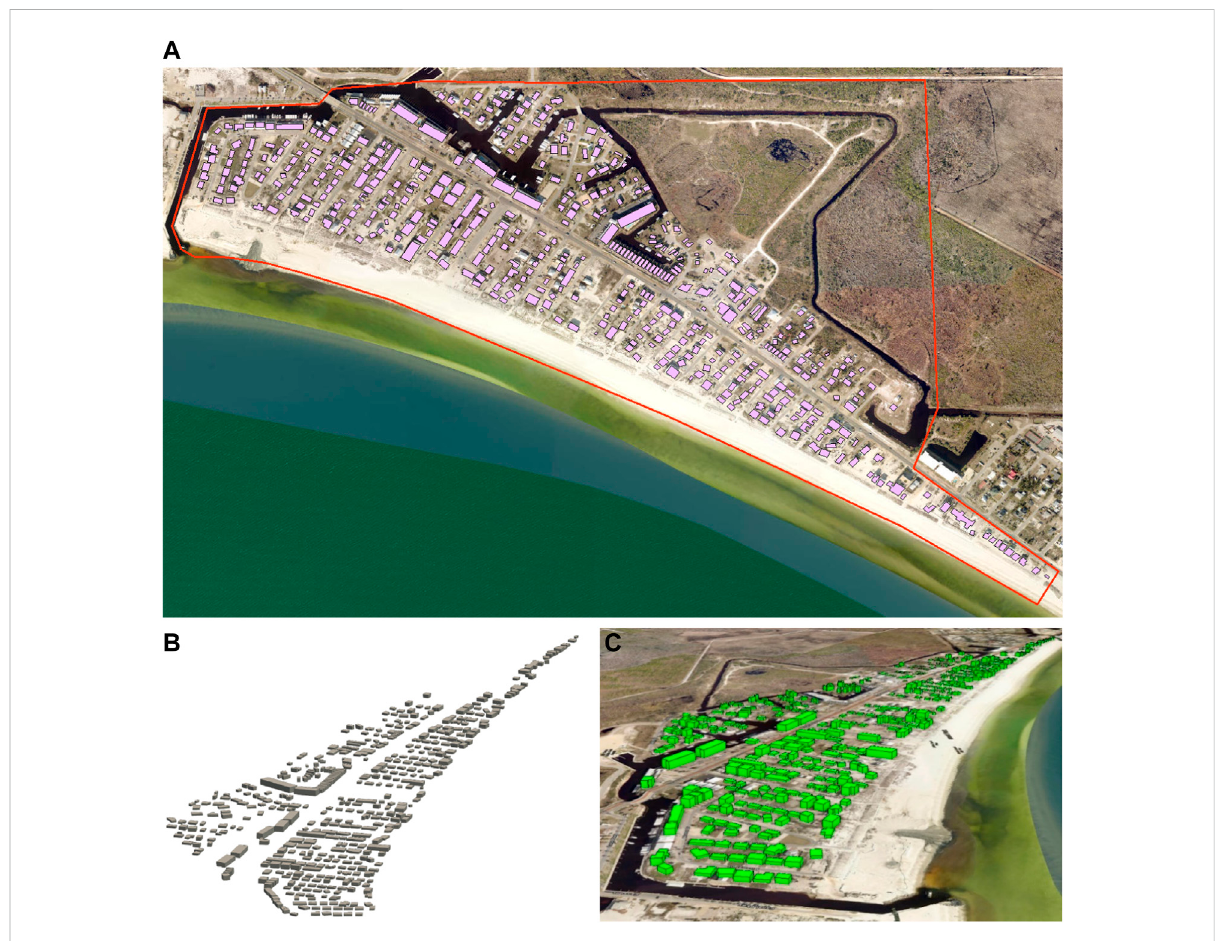
FIGURE 10 The building footprint for the study area in Mexico Beach, FL along with the new BIM and GIS model (A) Footprint for the buildings within the study area; (B) The BIM model for the community; (C) The BIM model of the community georeferenced in a 3-D GIS